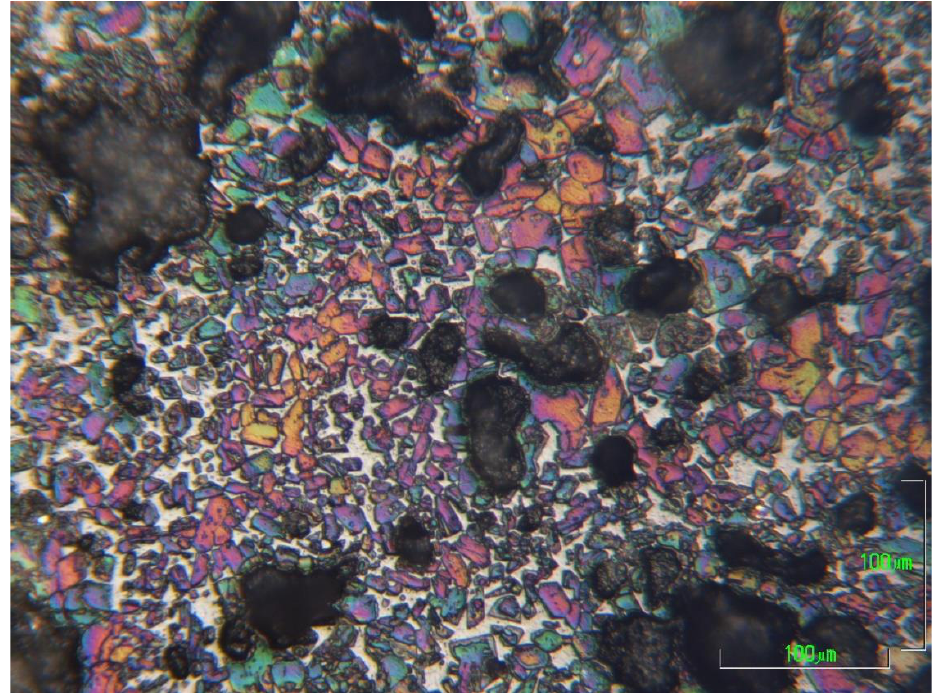
Figure 9. Image of optical microscopy of P 65A_1450.